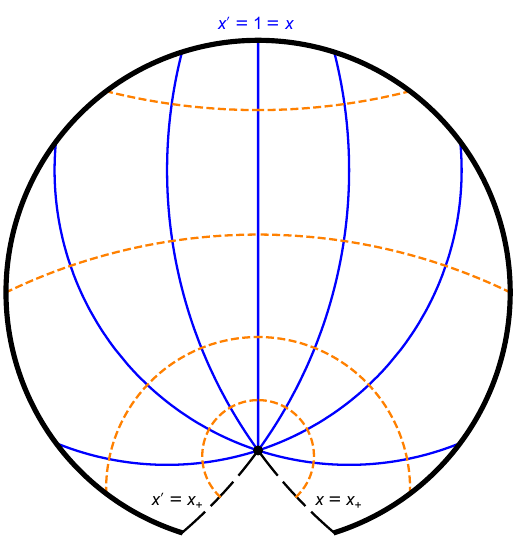
Figure 6 . The slowly accelerating conical deficit with A = 0 . 9 ‘ , pulled by a wall, mapped onto the Poincaré disk. The deficit is shown as a black point and accelerates southwards. A “wedge” is removed from the global space, with its edges x = x + and x 0 = x + (long-dashed black) identified to attain a wall. Several lines of constant x are shown in blue, with lines of constant y in dashed